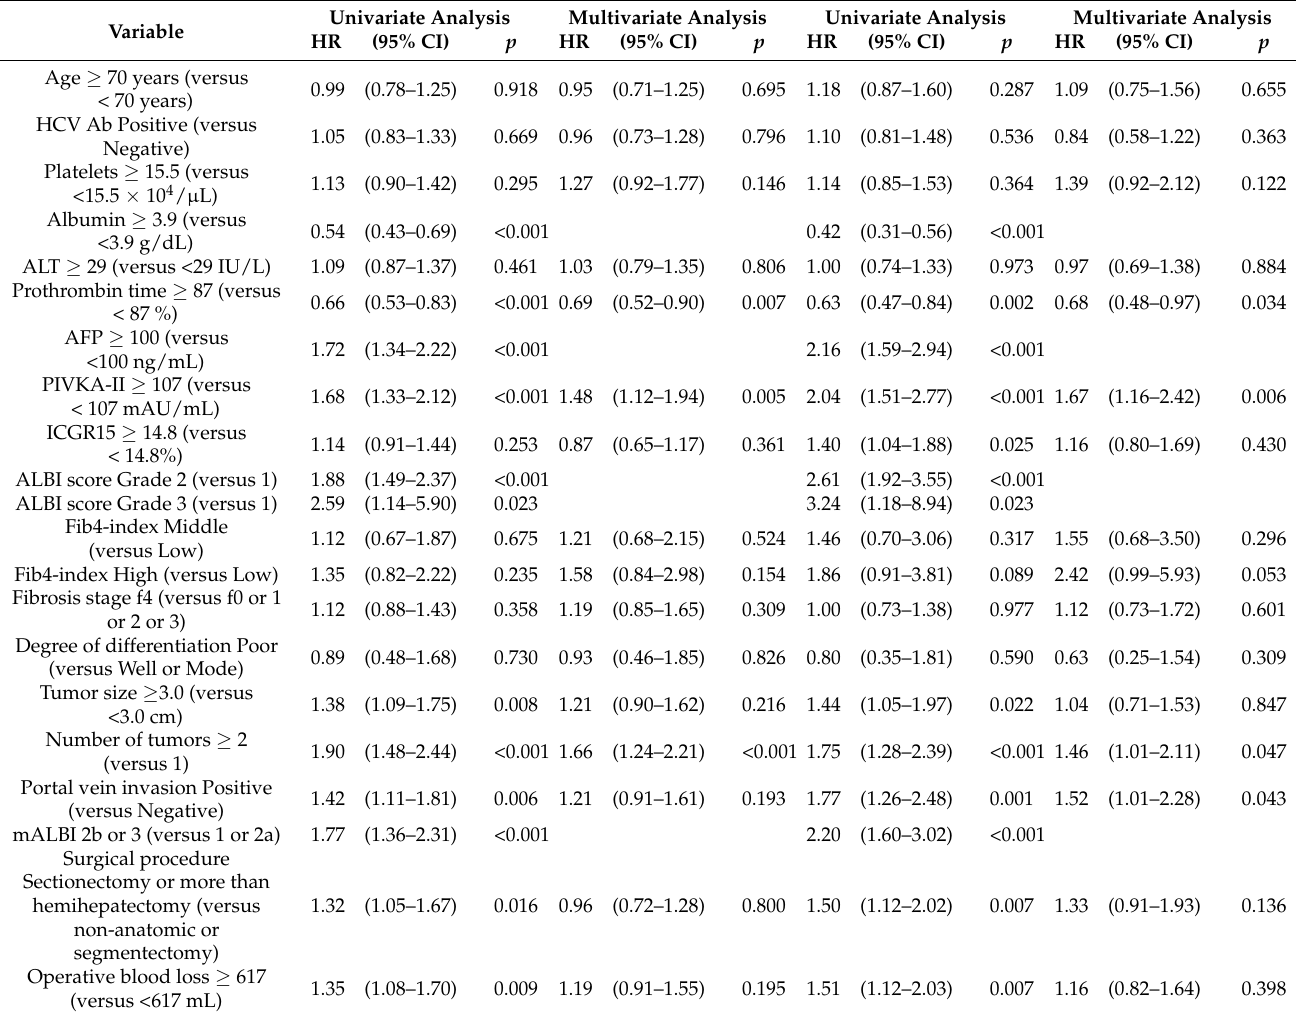
Table 3. Cox proportional hazards regression analysis for recurrence-free survival and overall survival in patients with hepatocellular carcinoma who underwent hepatic